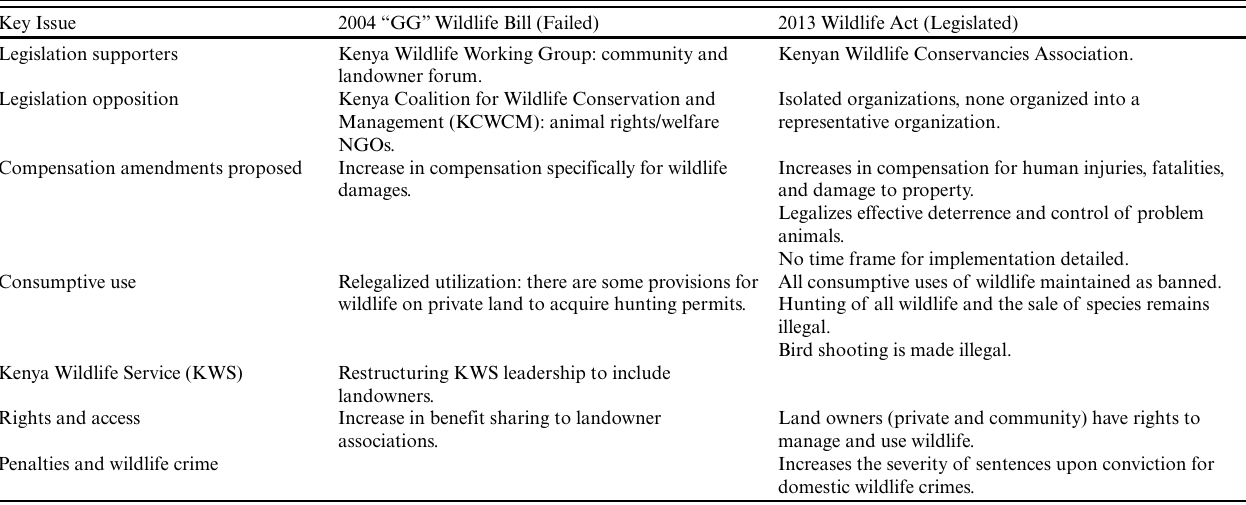
Table 2 . Comparison of legislative approaches between the 2004 and 2013 wildlife